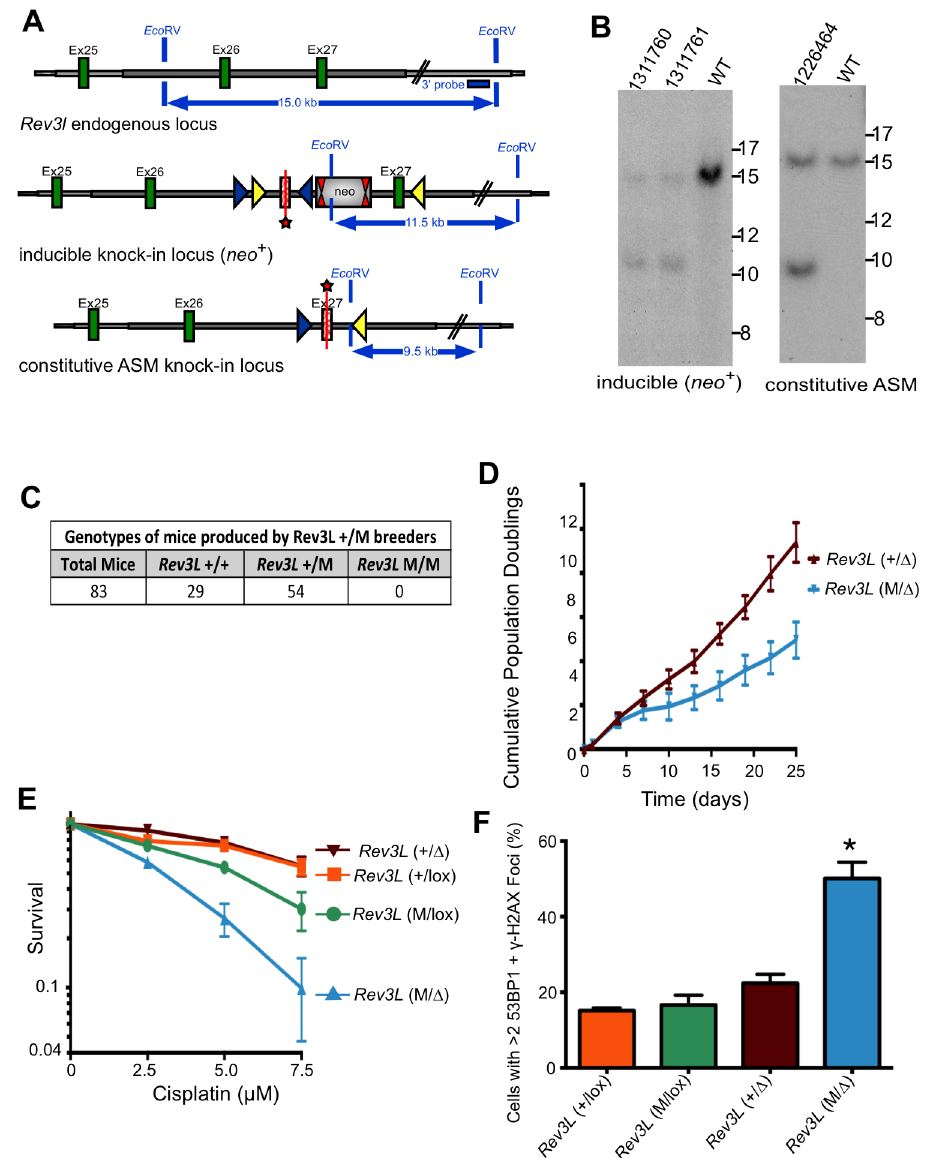
Fig 3. Knock-in mice and MEFs expressing active site mutant Rev3l have knockout phenotypes. (A) Diagram of the mouse Rev3l ASM knock-in allele, with the wild-type (WT) locus shown at the top. Green rectangles indicate Rev3l coding sequences and the gray line represents chromosomal sequence. In the middle diagram, FRT sites are represented by double red triangles, loxP sites by blue triangles and lox511 sites by yellow triangles. The targeted exon 27 (starred) carries D2773A and D2775A point mutations and is inserted in an inverted orientation between wild-type exons 26 and 27. Splicing donor and acceptor sites flanking wild-type and ASM exon 27 are kept intact. The knock-in was produced by a Cre-dependent genetic switch. First, the neomycin positive selection cassette (neo) was excised by breeding with C57BL/6 Flp deleter mice. A subsequent cross with Cre-expressing mice led to excision of the wild-type exon 27 and inversion of ASM mutant exon 27 into the functional orientation. In the constitutive ASM knock-in locus shown in the lower diagram, the D2773A/D2775A Rev3l gene is expressed under the control of the endogenous Rev3l promoter and wild-type Rev3l exon 27 is absent from the locus. Heterozygous ASM knock-in mice ( Rev3L +/M ) were then used for breeding. (B) Example of Southern blot analysis of (left) the inducible knock-in locus ( neo + ) and (right) the constitutive ASM knock-in locus. Genomic DNA of the tested animals was compared with C57BL/6 wild-type genomic DNA (WT). Eco RV digested DNA was blotted on a nylon membrane and hybridized with the external 3 ’ probe with the position shown at the top of part A. Restriction fragments of 15 kb, 11.5 kb and 9.5 kb were observed for the wild-type, inducible knock-in locus ( neo + )